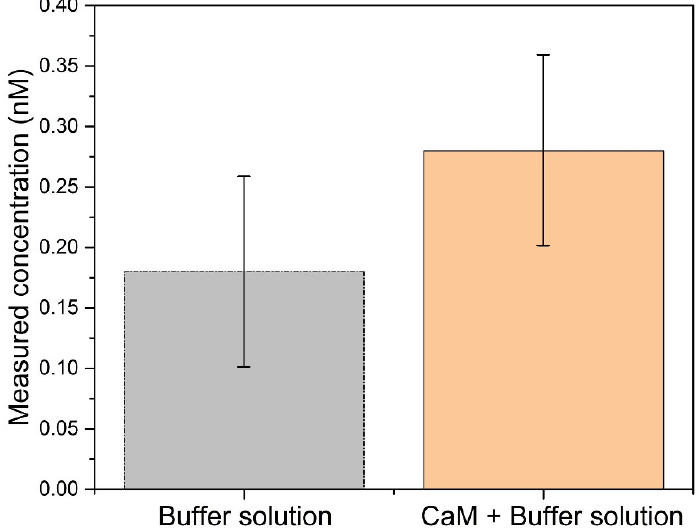
Figure 6. Measured concentrations using the TFBG functionalized with TRP immersed in buffer solution, in the presence or in the absence of CaM. solution, in the presence or in the absence of CaM.